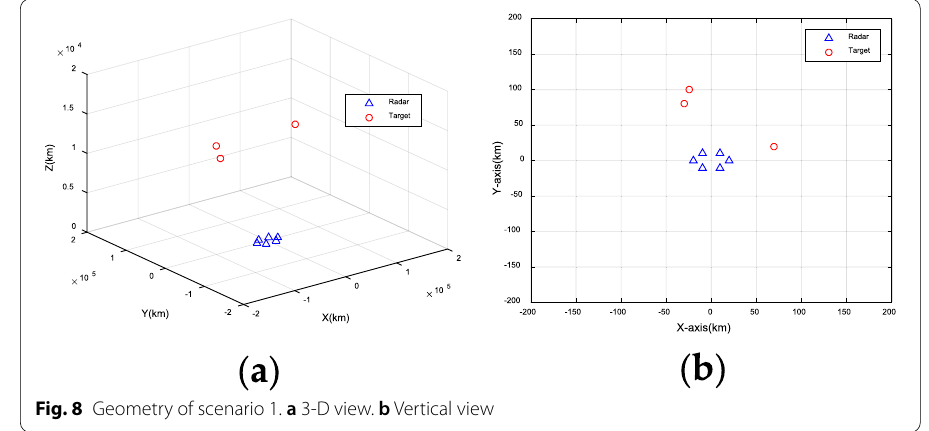
Fig. 8 Geometry of scenario 1. a 3-D view. b Vertical view